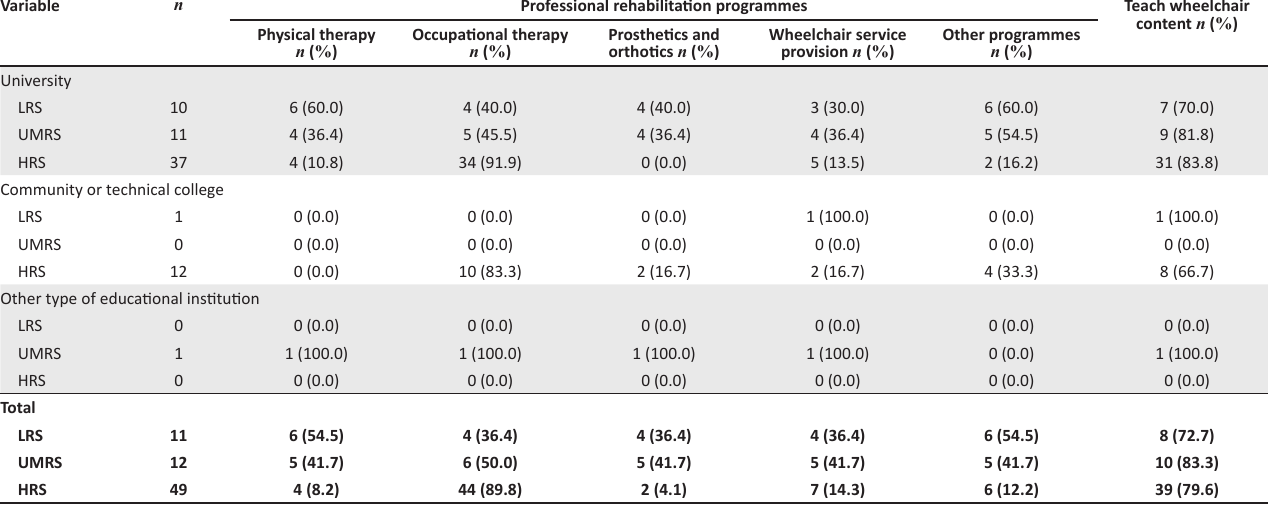
FIGURE 2: Countries of educational institutions respondents ( n = 72). TABLE 1: Professional rehabilitation programmes offered by types of educational institutions and resourced settings.